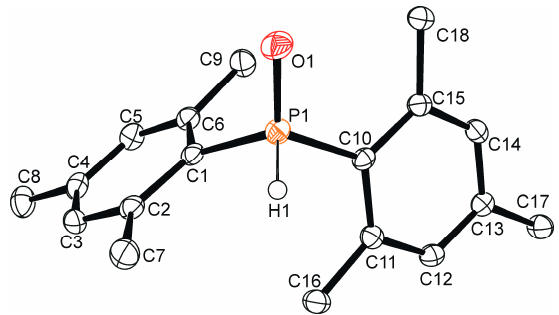
Figure 1. Single crystal structure of 1 . Ellipsoids are shown at the 50% probability level. Hydrogen atoms (excluding H1) have been omitted for clarity. Selected bond lengths (Å) and angles (°): P1–H1